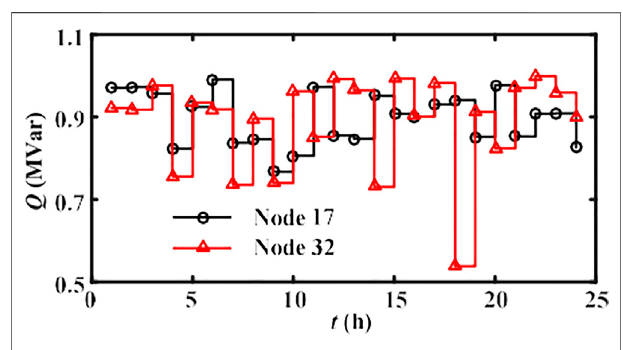
FIGURE 20 | Daily dispatch plan of the SVC.